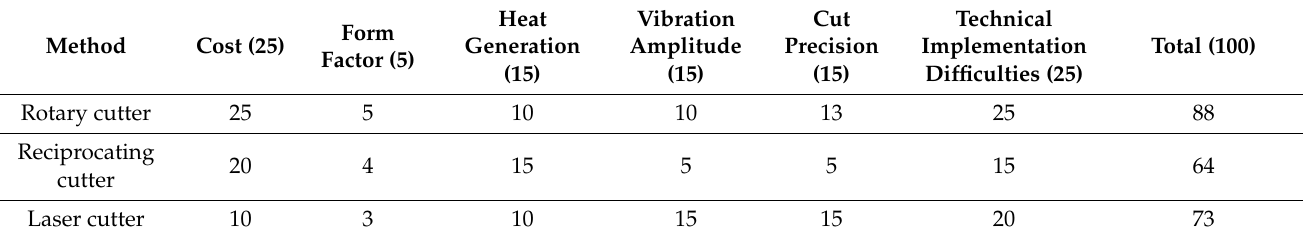
Table 1. Weighted decision matrix for three cutting